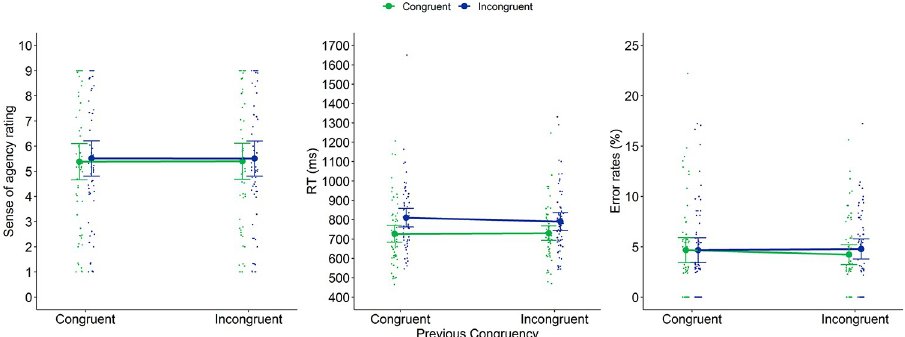
Fig 5. Sense of agency ratings (left panel), RTs (middle panel) and error rates (right panel) of Experiment 2 as a function of previous congruency and current congruency. Dots represent mean RTs for each participant in each condition (thus, each participant is depicted four times on this graph, once for each Previous × Current Congruency condition). Error bars represent 95% confidence intervals.